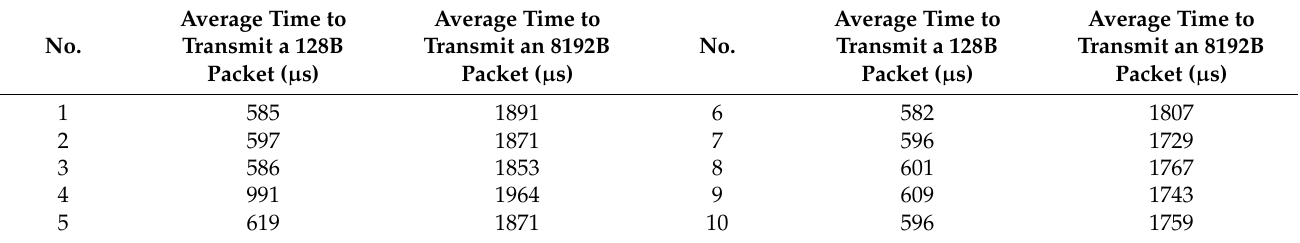
Table 1. Results of data transmission time measurement in the developed information exchange